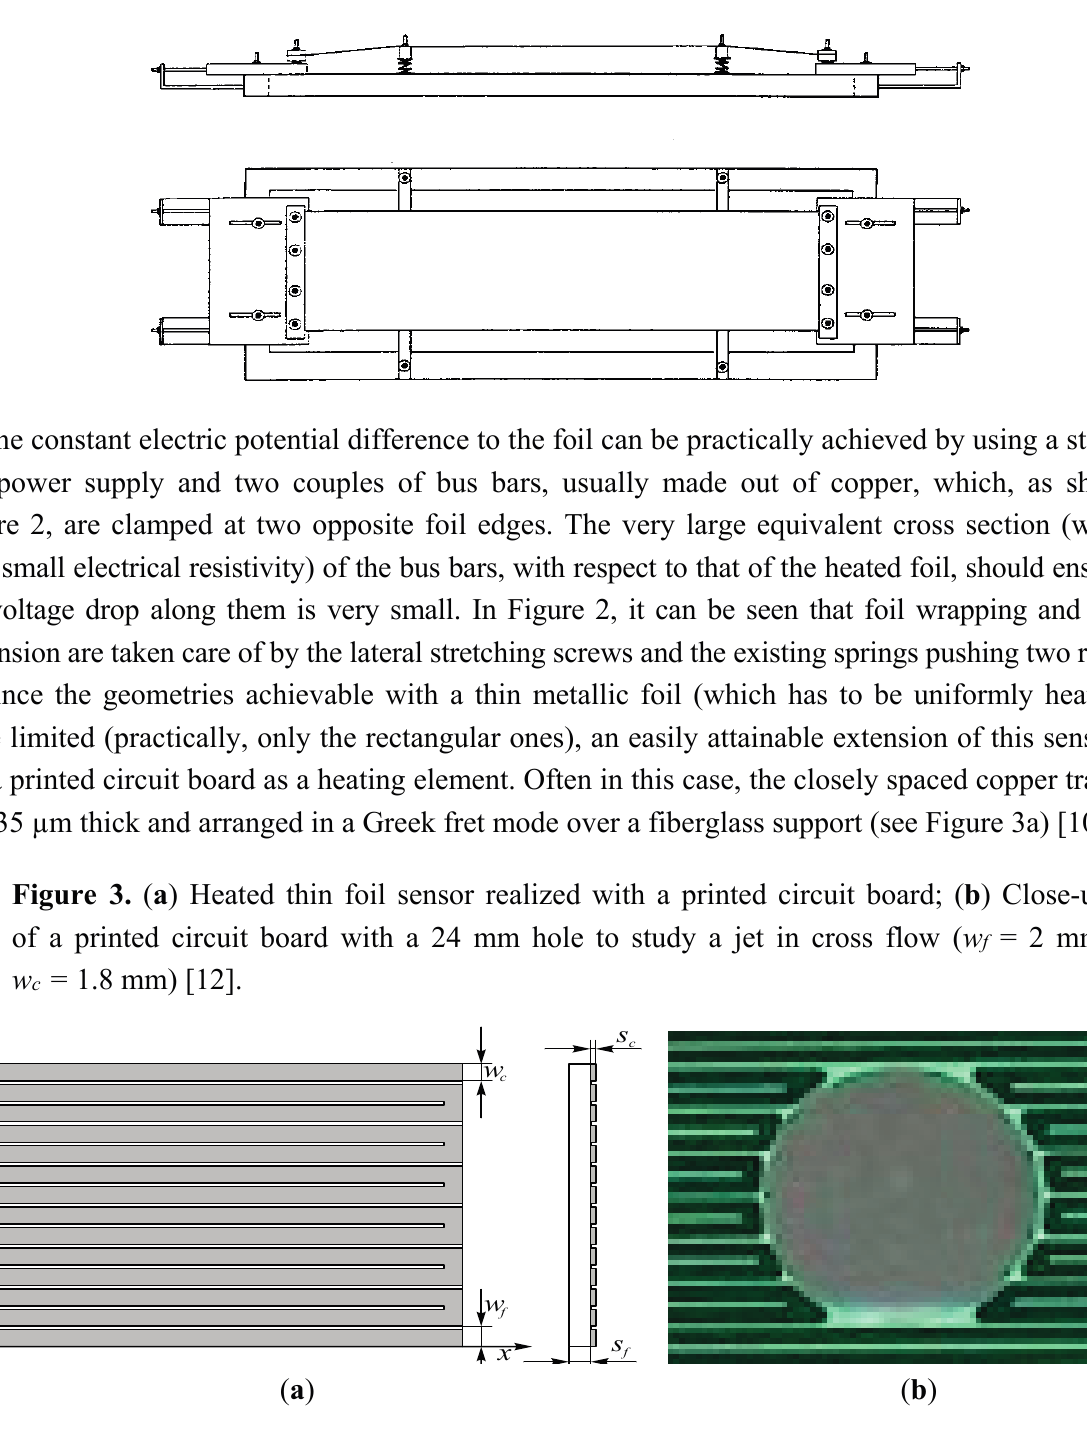
Figure 2. Sketch of a foil heater for natural convection studies. From Cardone and Carlomagno